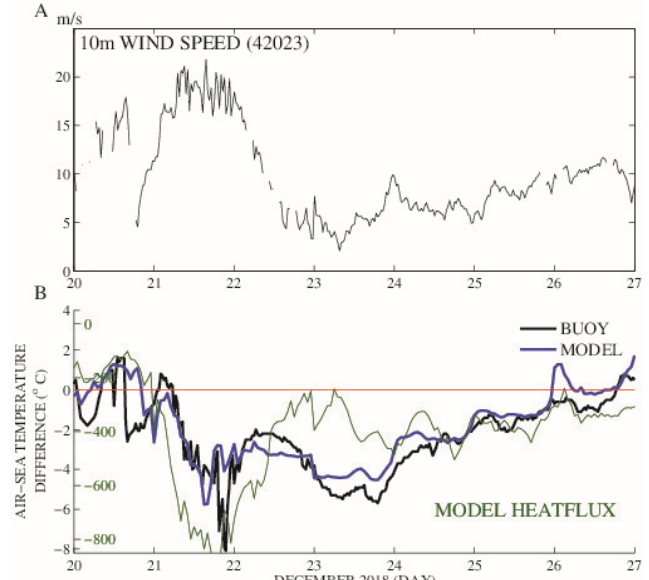
Figure 1. ( A ) Observed 10-m winds and buoy data and ( B ) air–sea temperature difference from buoy data (black) and Coupled Ocean-Atmosphere Mesoscale Prediction System (COAMPS) simulation (blue), and the COAMPS heat flux (- heat loss from the ocean) is shown (green, W m − 2 ). University of South Florida (USF) COMPS Buoy 42023 (26.010 N 83.086